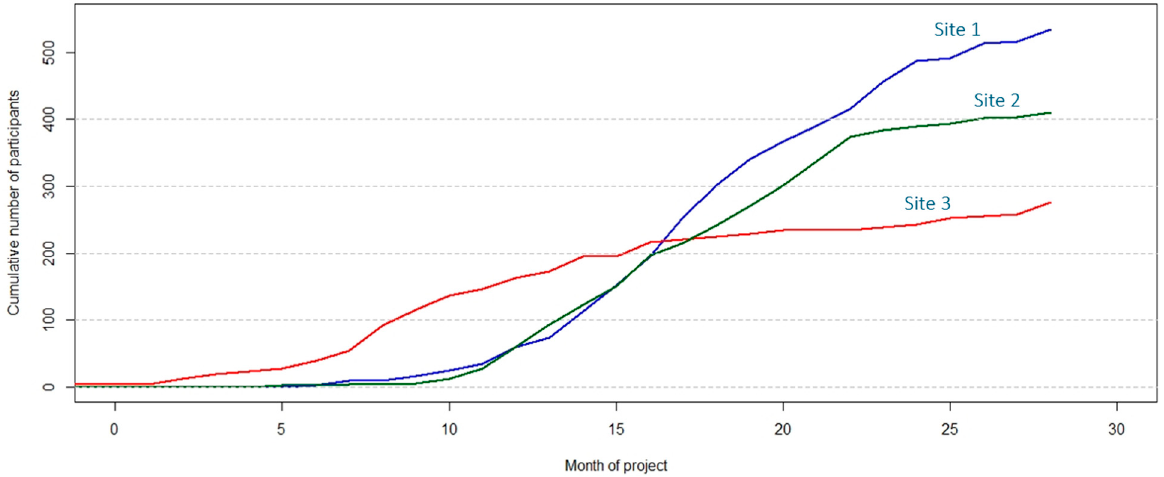
Figure 6. Graphical representation of the cumulative number of participants recruited in three exemplary recruitment sites to monitor the progress of the EULAT Eradicate GBC project against planned numbers.